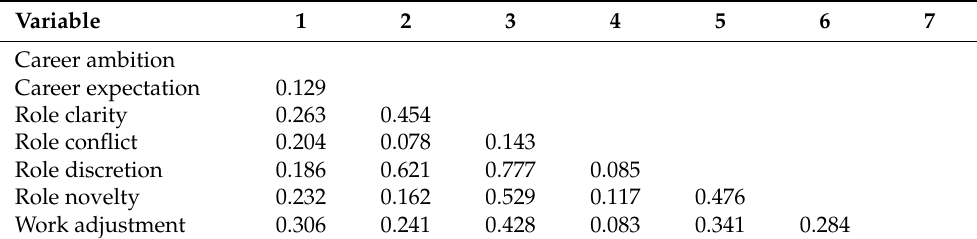
Table 5. HTMT Criterion.